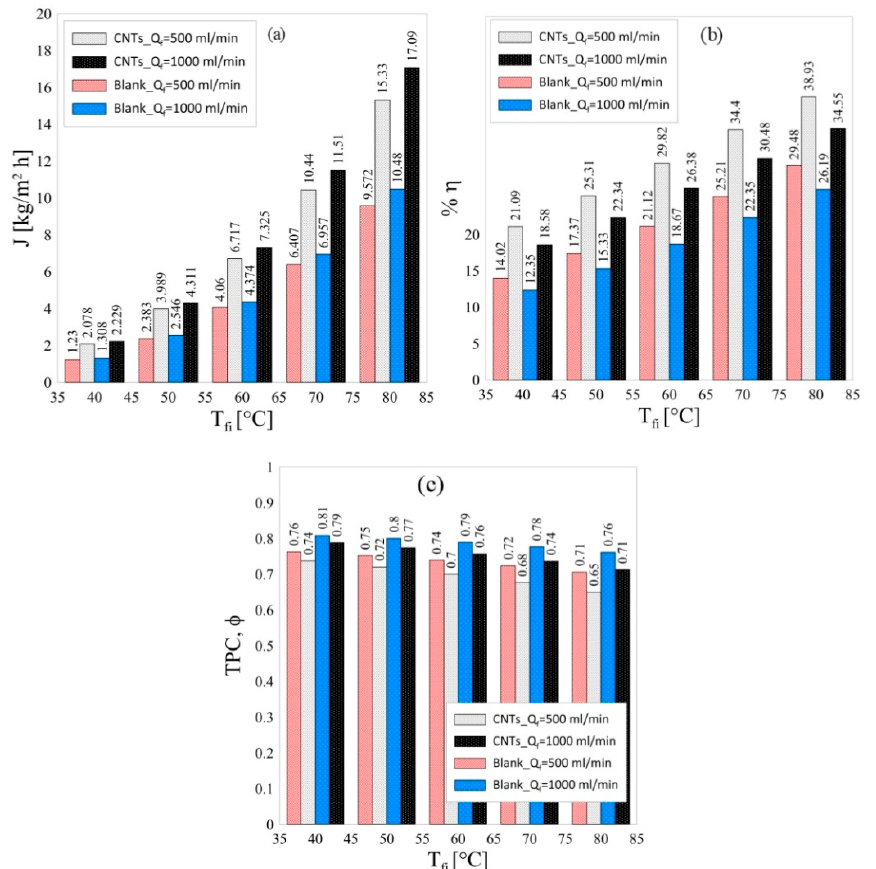
Figure 4. Effect of feed inlet temperature on ( a ) the system permeate flux ( 𝑱 ), ( b ) system thermal efficiency ( 𝜼 ), and ( c ) temperature polarization coefficient ( 𝝓 ) at two different flow rates and for blank and composite membranes